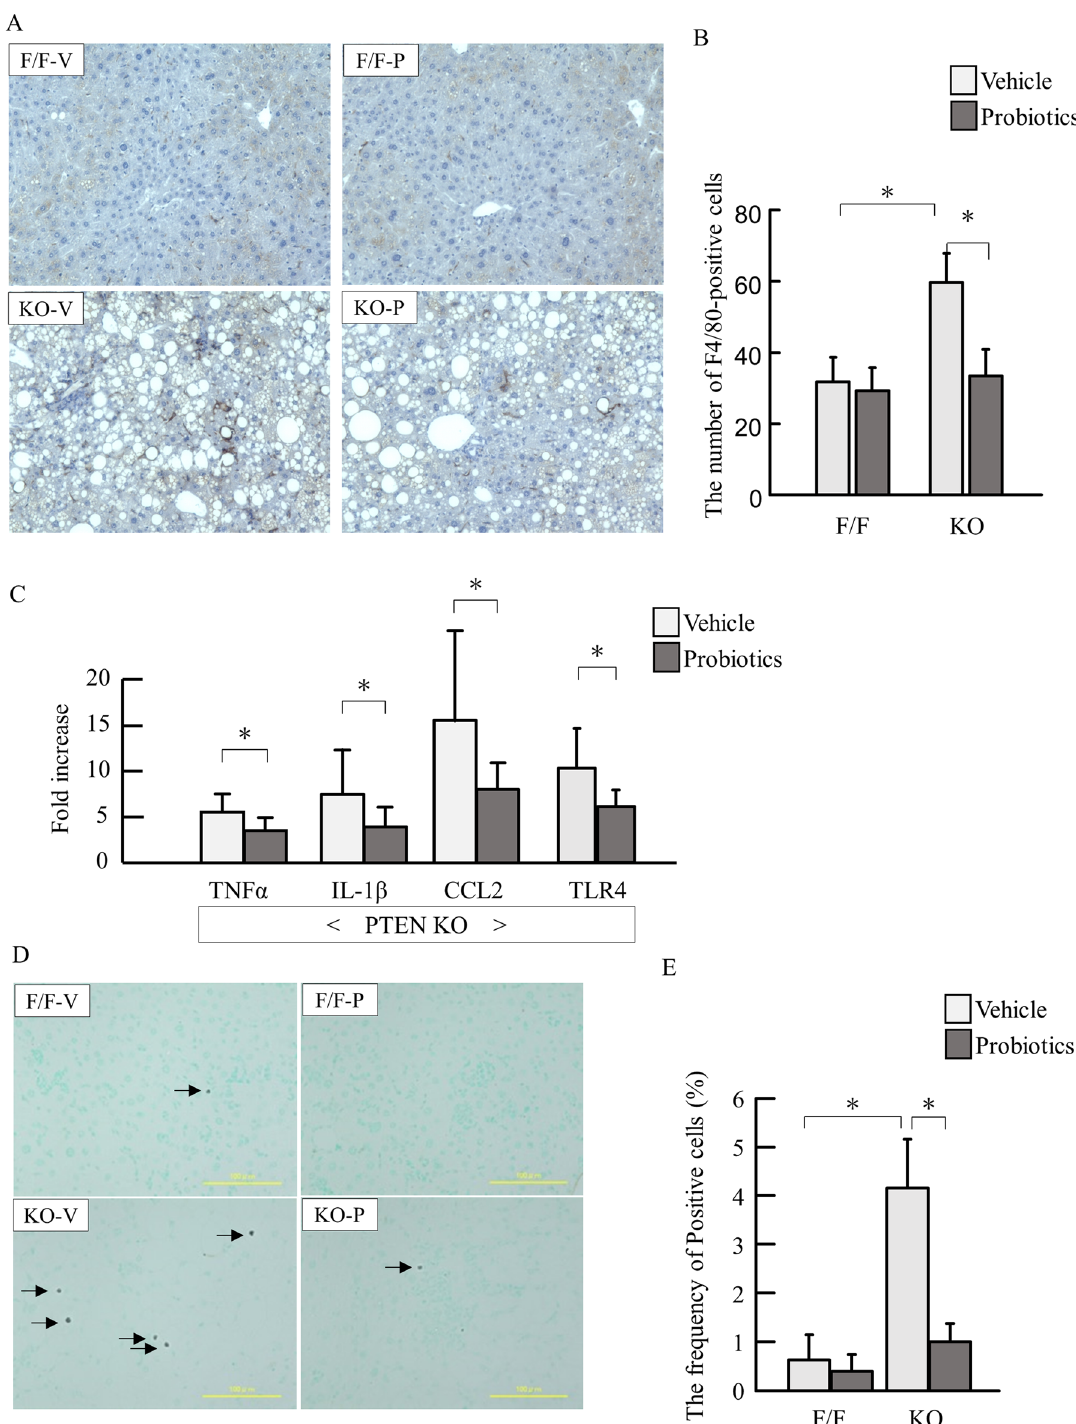
Figure 2. Hepatic inflammation and gene expression of cytokines. ( A ) Immunostaining for F4/80. F/F, PTEN F/F mice; KO, PTEN KO mice; V, vehicle; P, probiotics; ( B ) The number of F4/80-positive cells. ( C ) mRNA expression of inflammatory markers in PTEN KO mice (Experiments were performed in technically duplicate). ( D ) The representative photos of TUNEL staining. E. The frequency of TUNEL-positive cells. Groups were analyzed using the student’s t -test. Data were presented as mean ± standard deviation.* P < 0.05 (each group n =